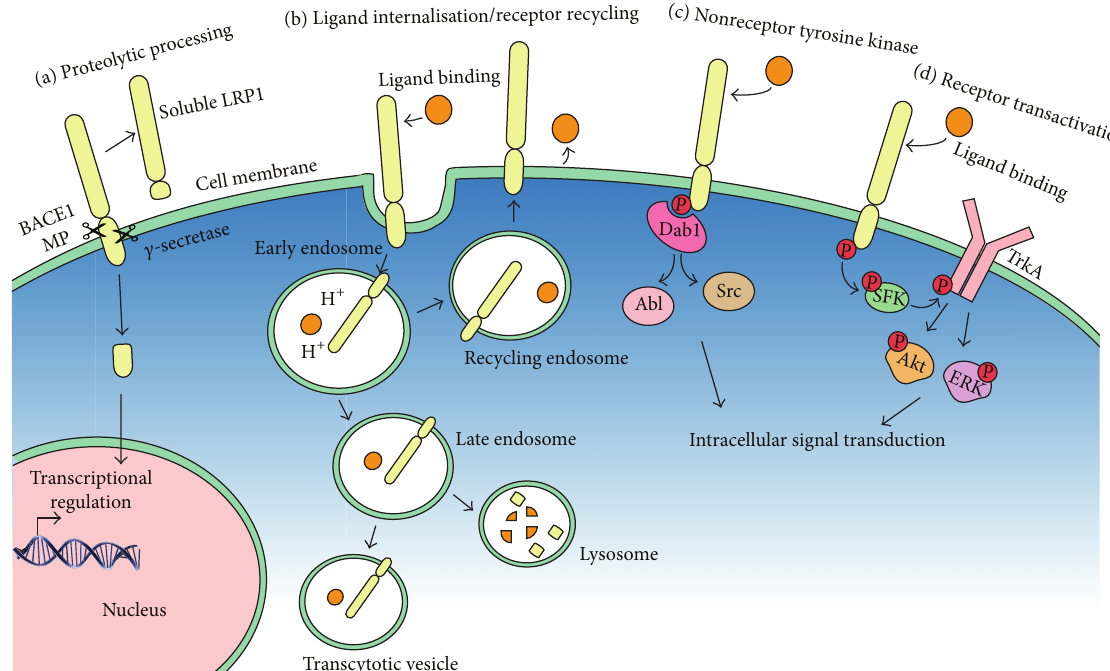
Figure 2: Signalling mechanisms employed by LRP1. (a) The extracellular domain of LRP1 can be shed following cleavage by beta-site APP cleaving enzyme 1 (BACE1) and metalloproteinases (MP) producing a soluble form of LRP1 (sLRP1). The intracellular domain can be cleaved by 𝛾 -secretase and is thought to translocate to the nucleus to influence gene transcription. (b) Ligand binding to LRP1 can result in receptor and ligand internalisation. Once internalised, the ligand/receptor complex can be processed in a multitude of ways, including degradation by lysosomes or resecretion via transcytotic and recycling vesicles. Note that while they are depicted together, ligand and receptor/s are trafficked independently.(c)SpecificregionsontheintracellularregionofLRP1interactwithadaptorproteinssuchasDisabled-1(Dab1),whichinteracts with the NPXY motifs and can recruit nonreceptor tyrosine kinases such as Src and Abl allowing signal transduction. (d) Activation of LRP1 by specific ligands can transactivate other receptors such as tropomyosin receptor kinase A (TrkA), which can then activate downstream signalling pathways to regulate cell